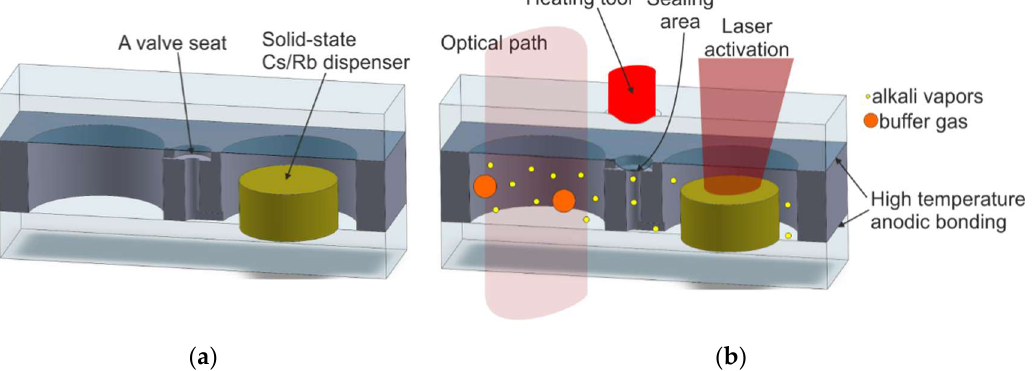
Figure 15. The MEMS cell with microvalve: ( a ) cross section with visible valve seat and solid-state dispenser, ( b ) laser-induced dispensing and closing of the microvalve.